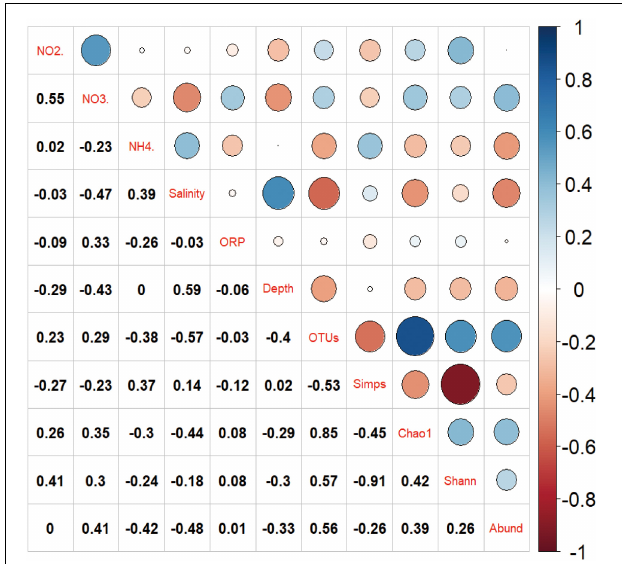
FIGURE 5 | Pearson correlation analysis of environmental parameters and diversity. Chaol stands for Chaol estimator, Shann stands for Shannon index, Simps stands for Simpson index, N02 stands for nitrite, N03 stands for nitrate and NH4 represents ammonia, OTUs represents the number of OTU and Abund stands for the abundance of nxrB gene. Blue and red denote positive and negative correlations, respectively. The r -values of pearson correlation analysis were shown in the